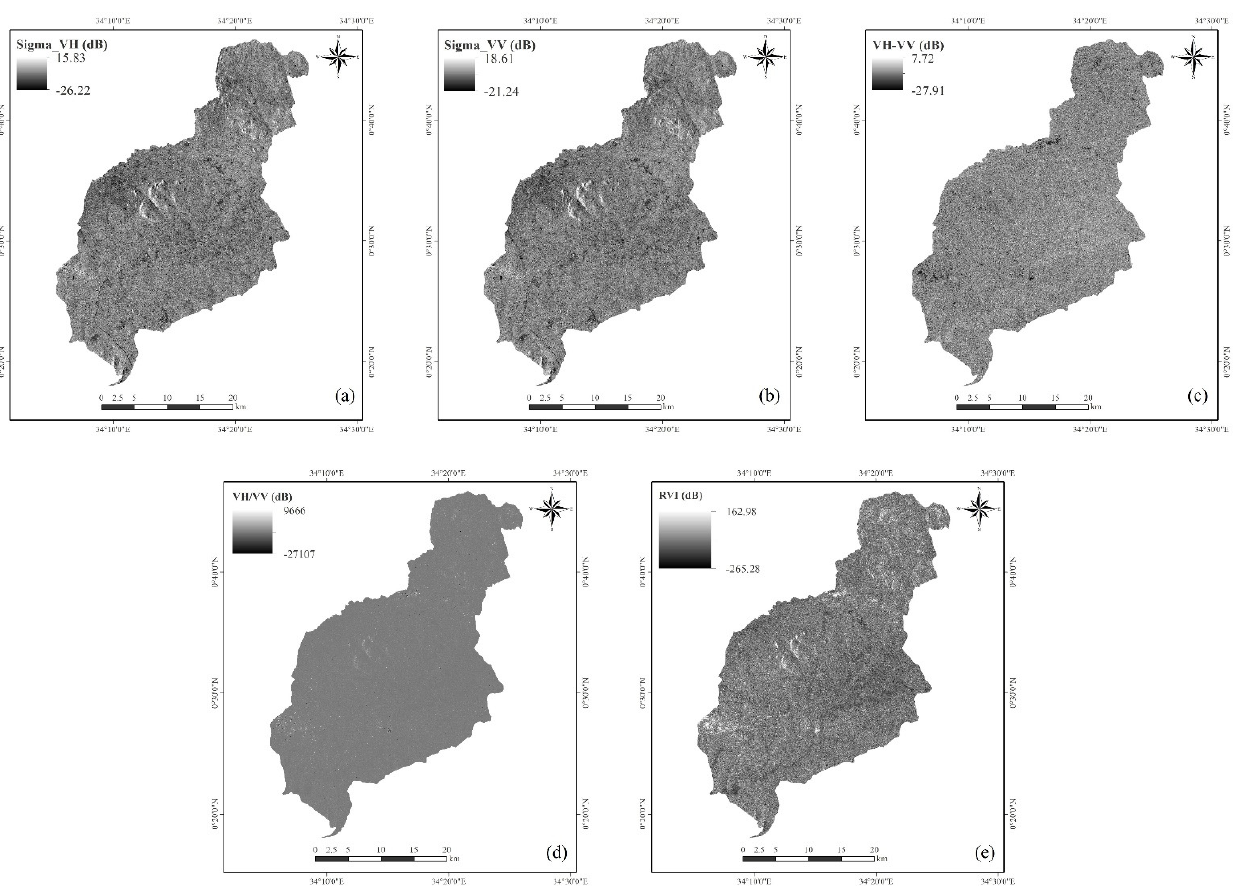
Figure 5. Remotely sensed variables derived from Sentinel-1 SAR data: ( a ) VH, ( b ) VV, ( c ) difference (VH − VV), ( d ) ratio, and ( e ) RVI.